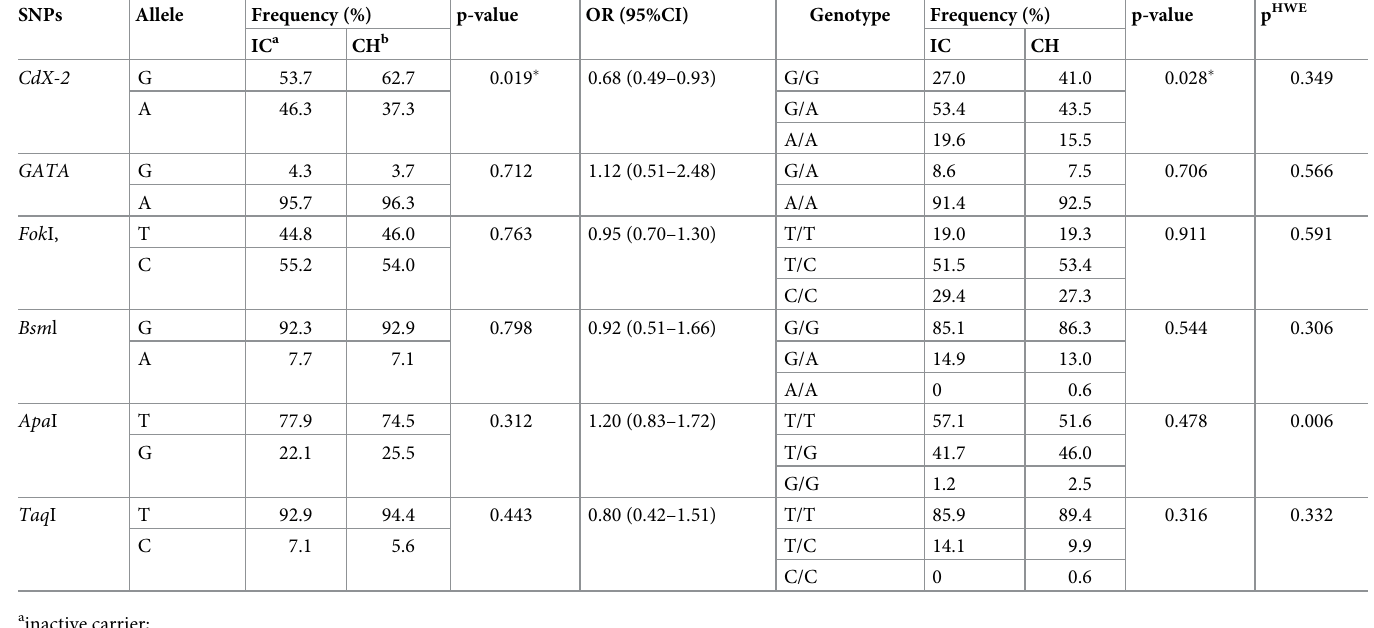
Table 2. The proportion of allele frequency of CdX-2 in IC and CH was 53.7% and 62.7% for the G allele and 46.3% and 37.3% for the A allele, which was statistically significant (p = 0.019). Table 2. Allele and genotype frequencies of VDR SNPs in HBV inactive carrier and chronic hepatitis phases. SNPs